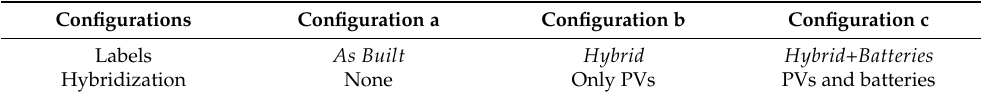
Table 5. Configurations for the LCOH calculation.